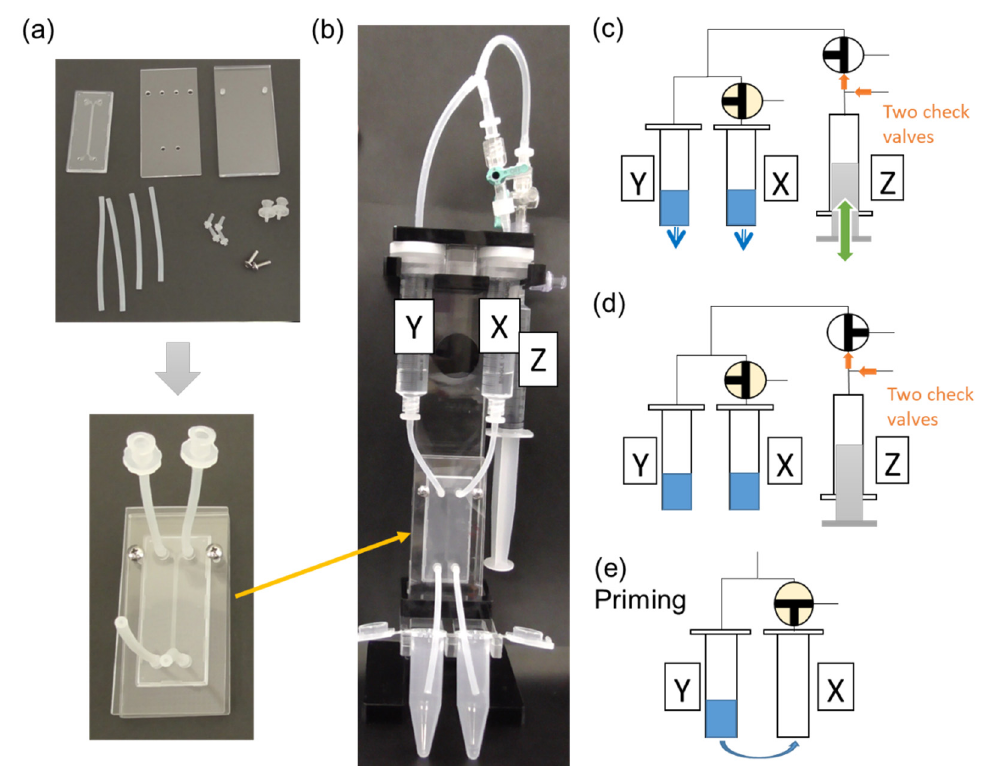
Figure 2. ( a ) Photographs of setting the microfluidic DLD device into a polyacrylic manifold. ( b ) Connection of the air pressure pumping system to the microfluidic DLD device. ( c ) A schematic representation of the mechanism to make fluids flow inside the microfluidic channel by increasing air pressure inside syringes X and Y. The two check valves work to increase the air pressure in syringes X and Y. ( d ) A schematic representation of the mechanism to stop fluid flow and restore atmospheric pressure inside syringes X and Y by turning the three-way stopcock. ( e ) A schematic representation of the mechanism of air removal in the microfluidic channel during the initial run.